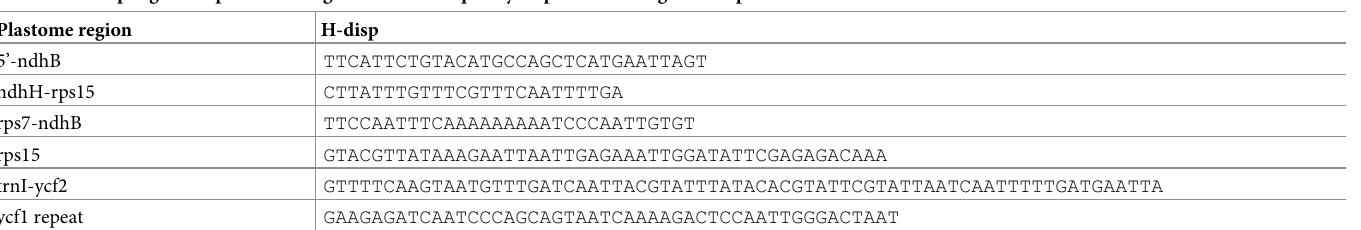
Table 3. H-disp regions captured through the k-mer frequency dispersion among the samples. Plastome